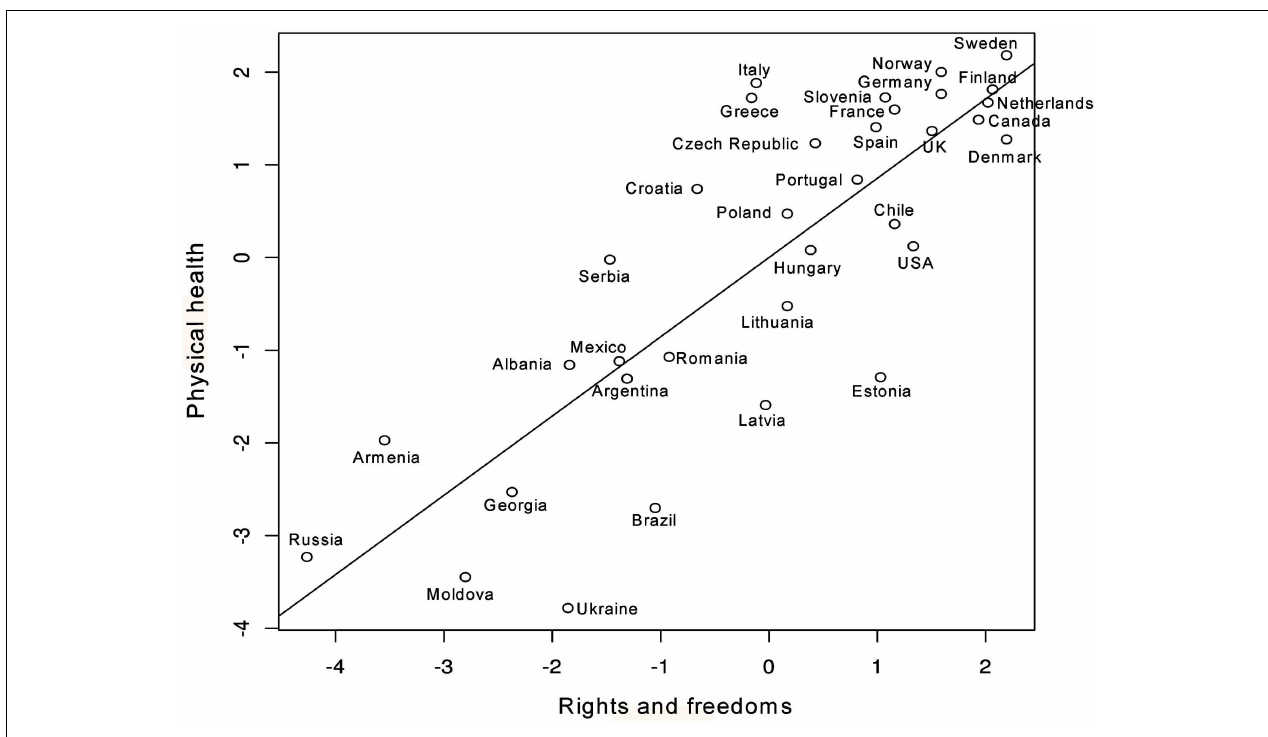
FIGURE 8 | Scatterplot of rights and freedoms versus physical